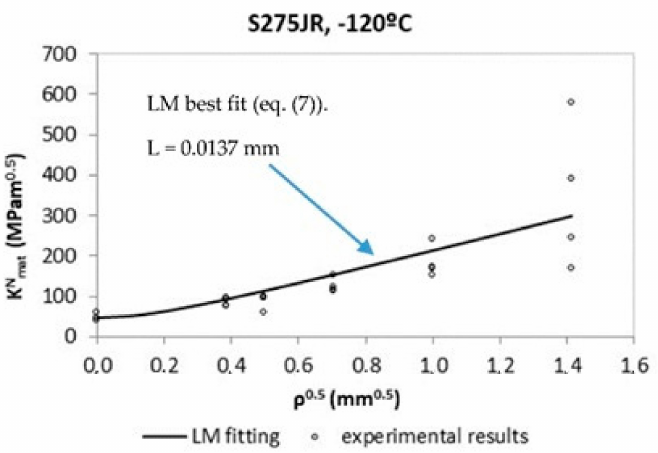
Figure 1. Experimental notch fracture toughness results, Line Method (LM) fitting and derivation of the corresponding critical distance. Steel S275JR at − 120 ◦